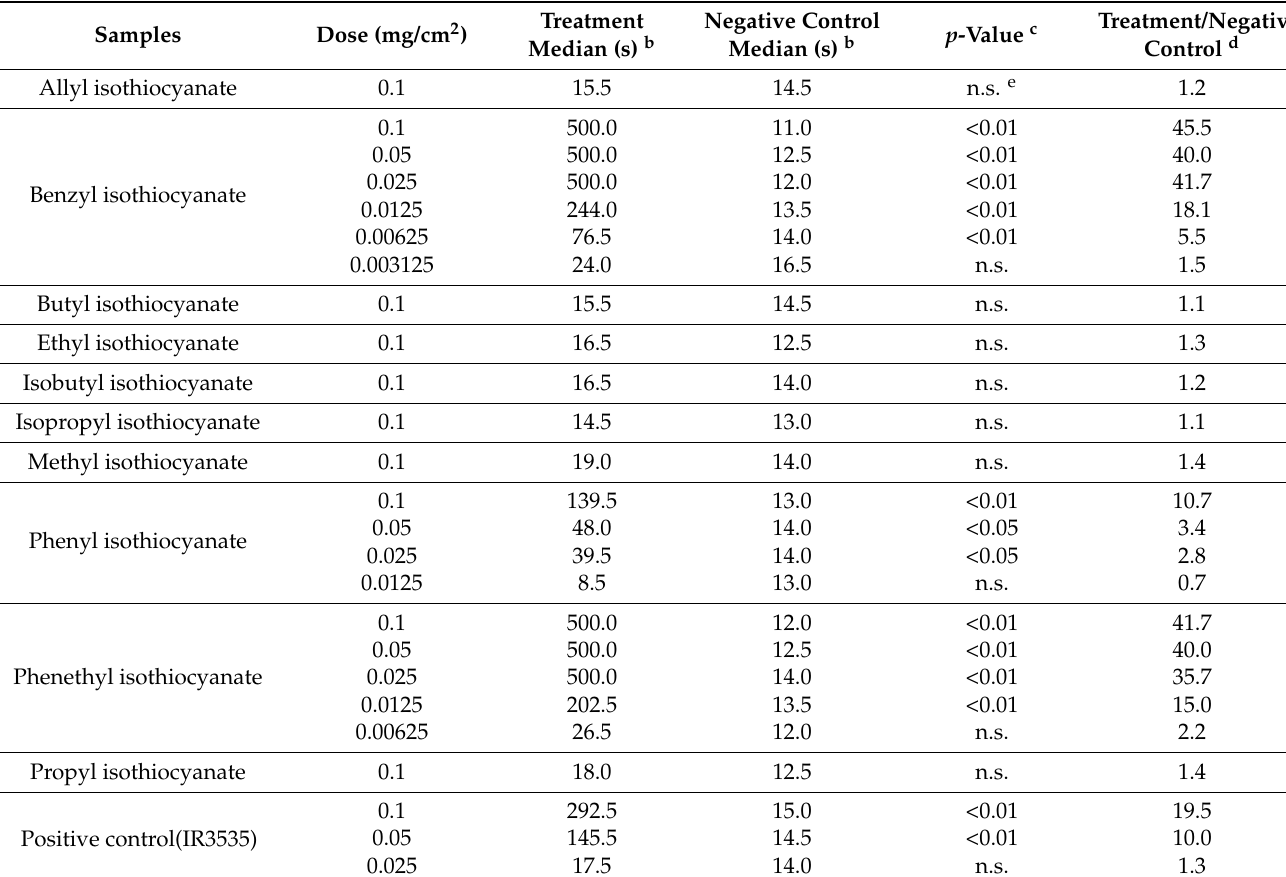
Table 2. Repellent effects of phenethyl isothiocyanate isolated from Armoracia rusticana root oil and its derivatives against Haemaphysalis longicornis nymphs at different doses using a filter paper bioassay a .